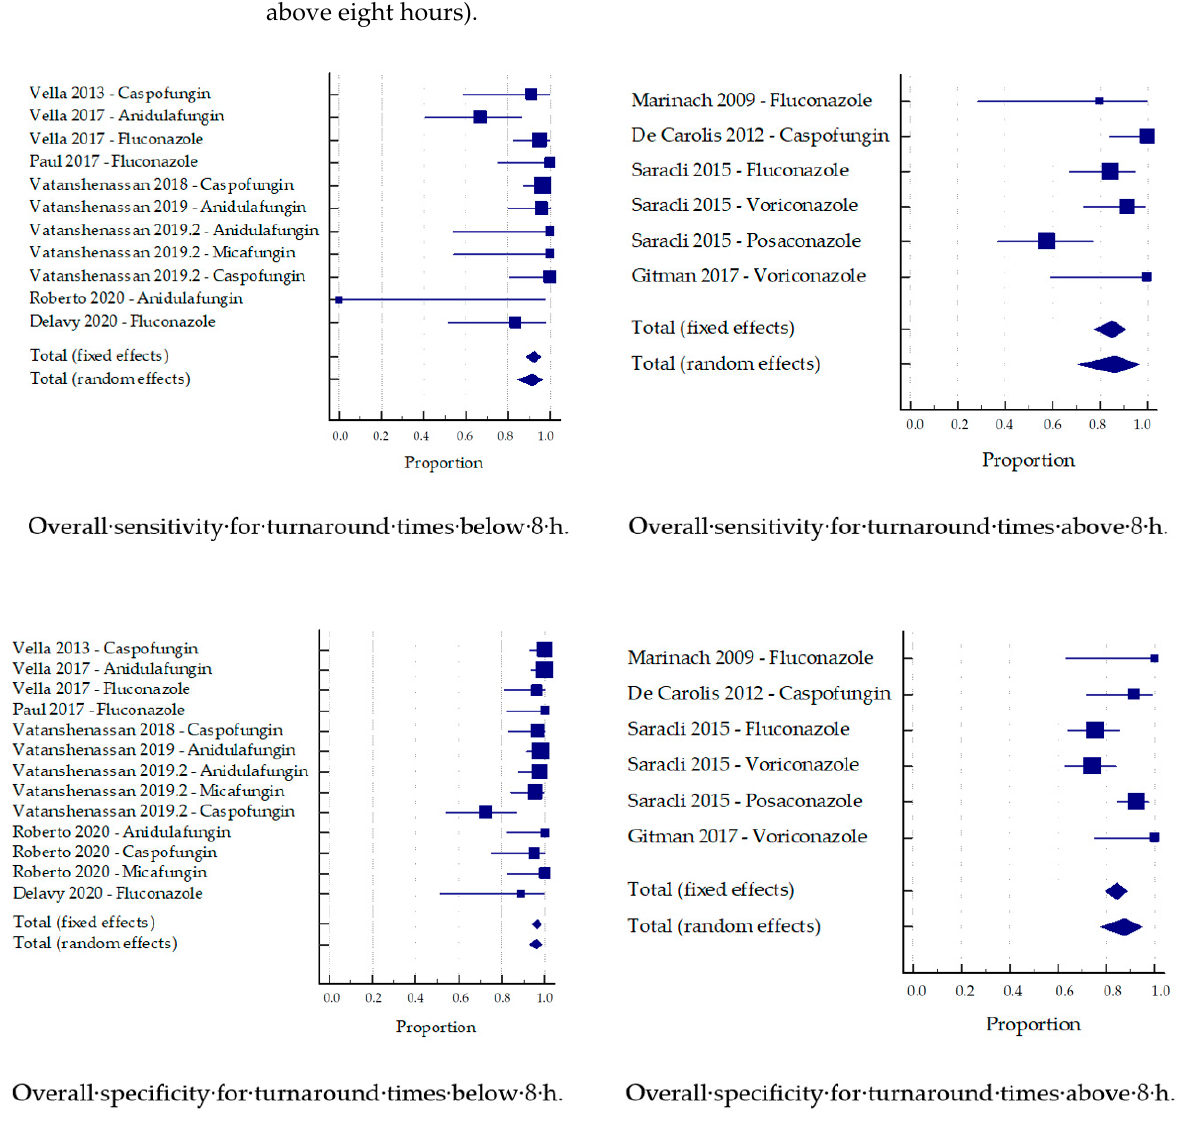
Figure 6. Sensitivity and specificity by turnaround time.